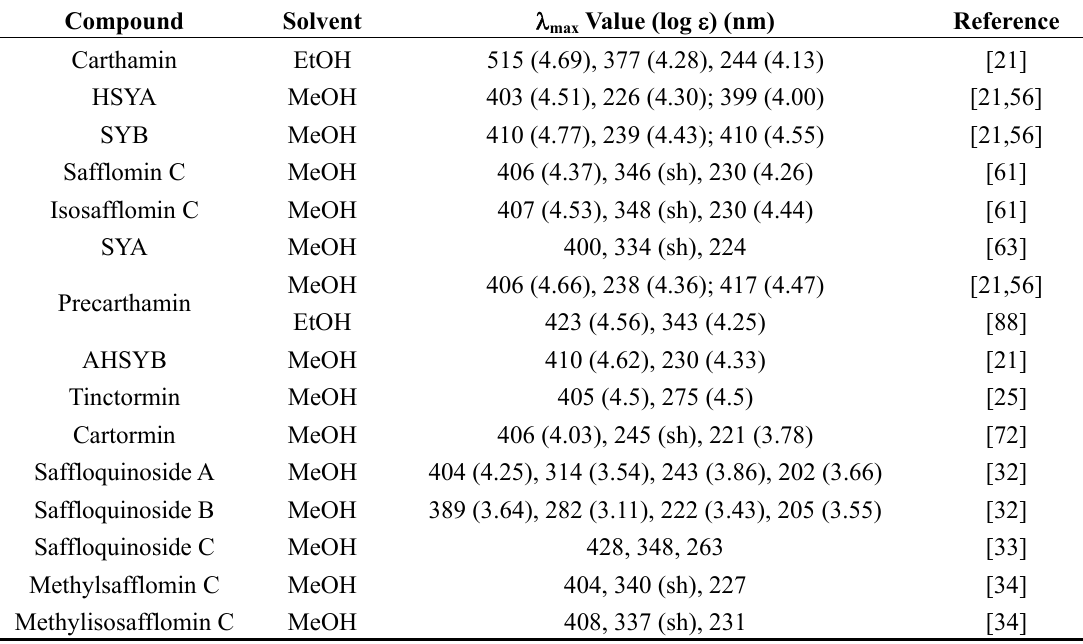
Table 7. UV-vis spectra data of quinochalcone C